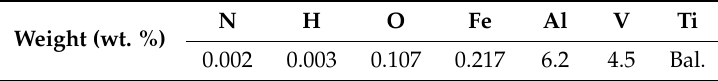
Table 1. Experimental chemical composition of Ti-6Al-4V alloy rivets.